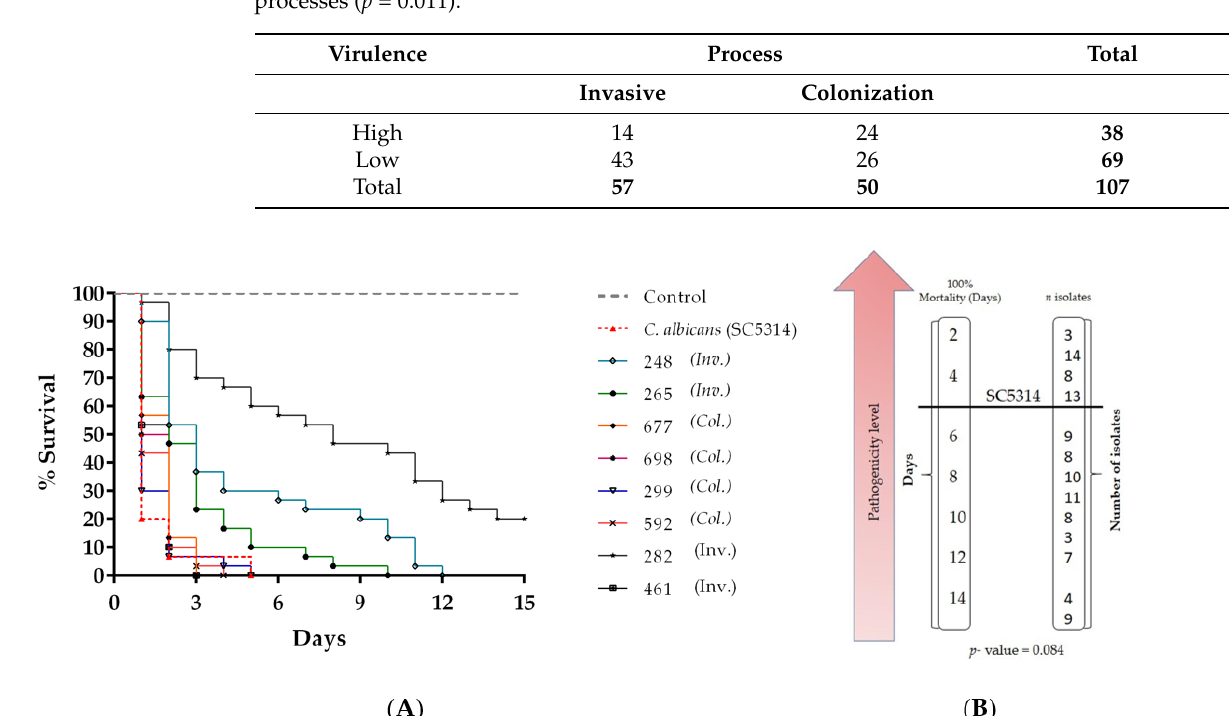
Table 2. Strains of C. auris with high and low virulence, exhibiting a statistically association with processes ( p = 0.011).